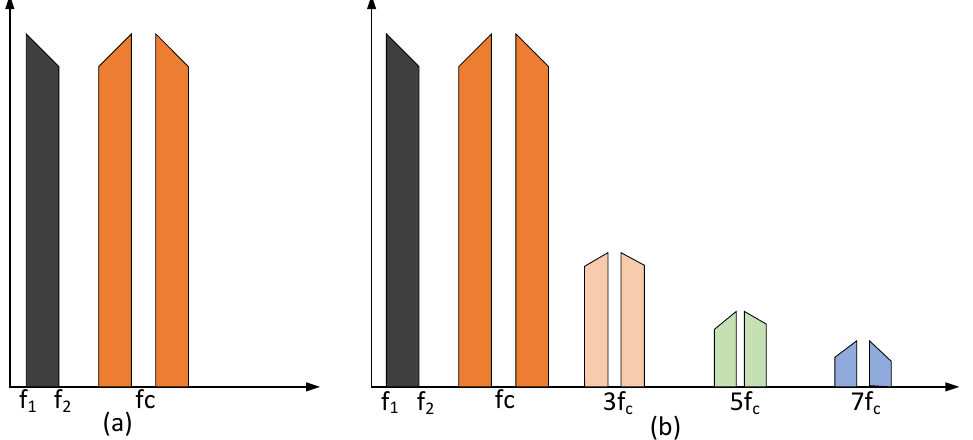
Figure 3. Output spectra of ( a ) a multiplier or a modulator with an LPF and ( b ) an unfiltered modulator